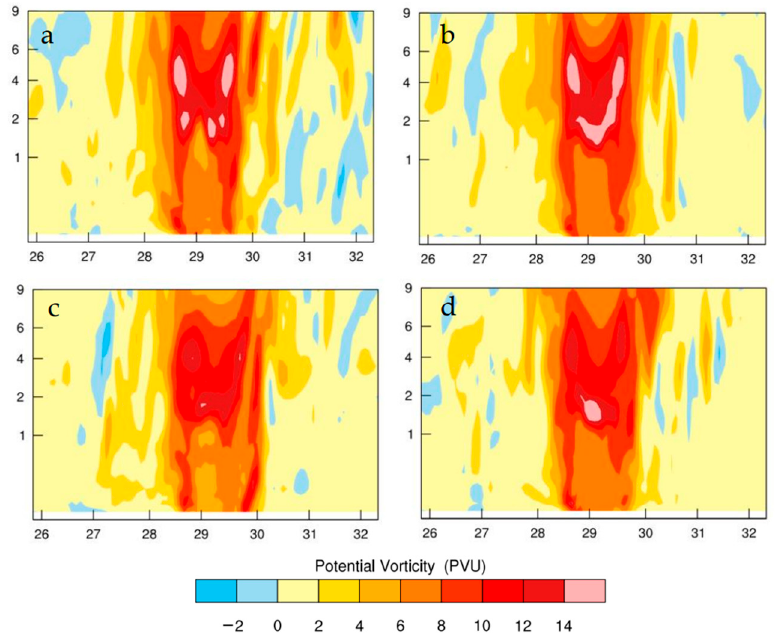
Figure 7. The same as Figure 5, but for potential vorticity (unit: PVU; vertical axis is height in km).